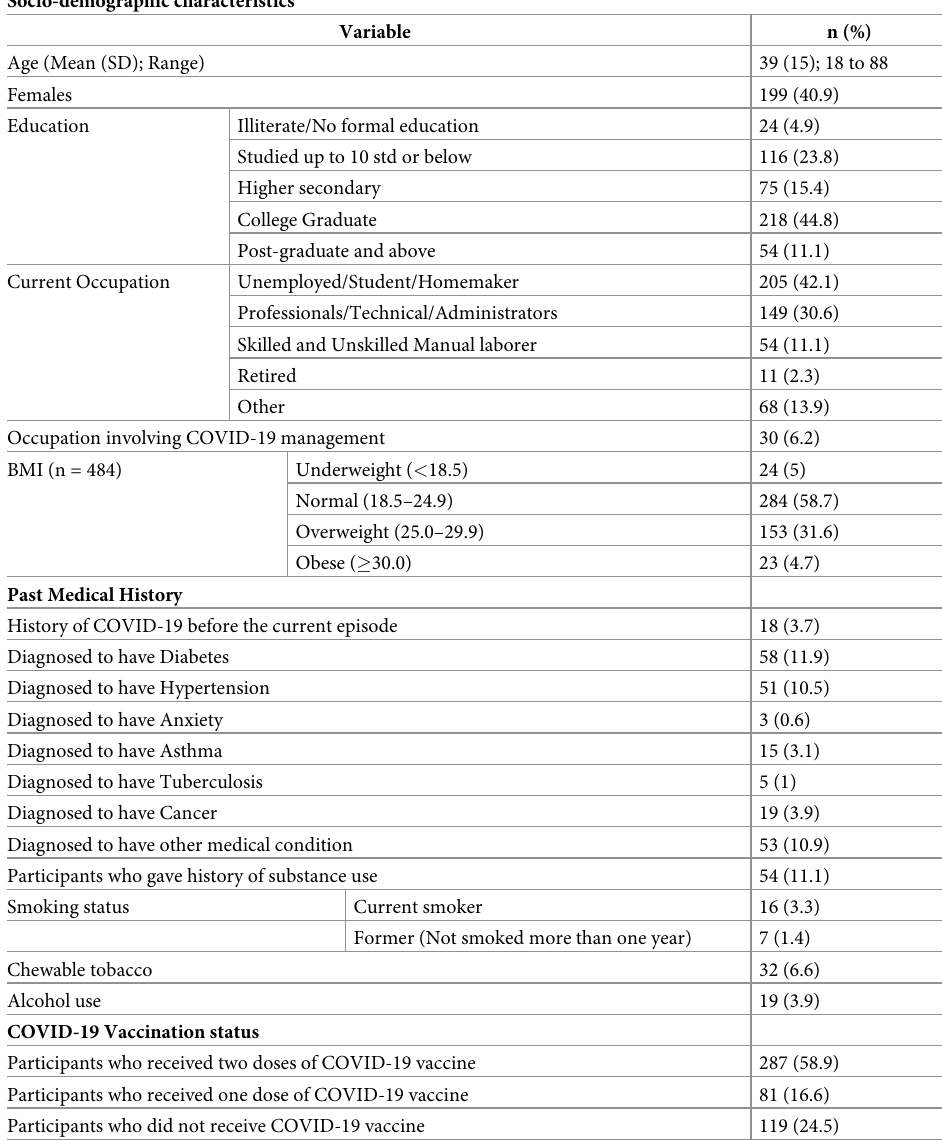
Table 1. Sociodemographic characteristics, past medical history, and vaccination status of participants (n = 487). Socio-demographic